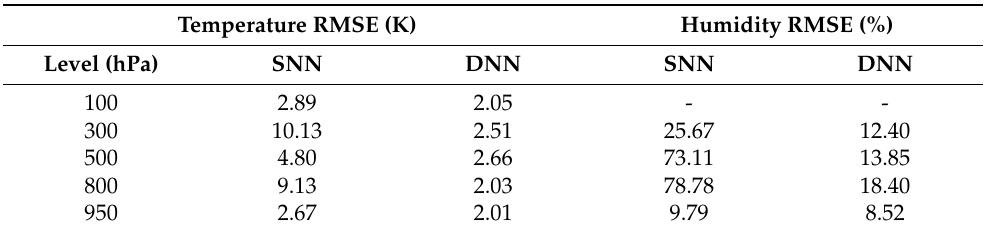
Figure 11. The retrieval RMSEs of the NN-based retrievals using the simulations with respect to ERA-Interim. Table 6. Summary of the retrieval RMSEs of the NN-based retrievals using the simulations with respect to ERA-Interim.